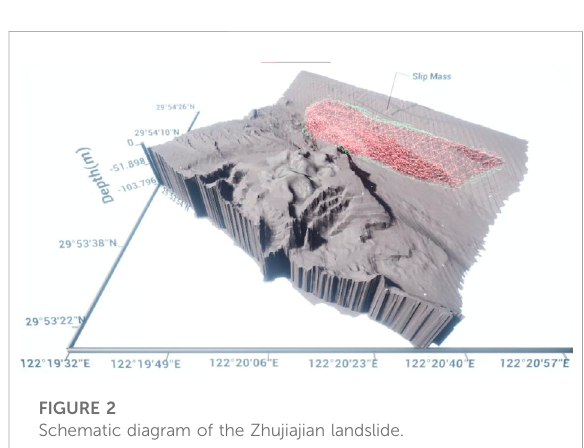
FIGURE 2 Schematic diagram of the Zhujiajian